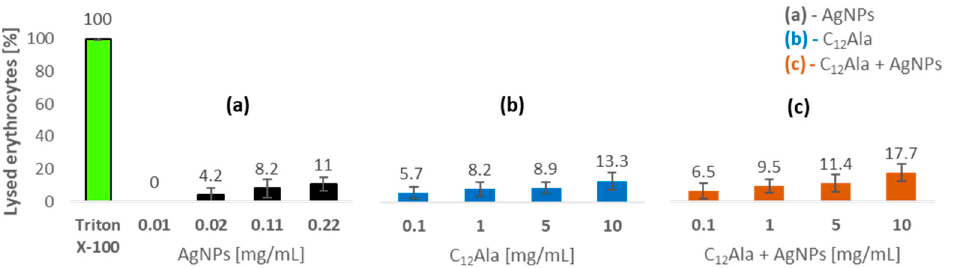
Figure 11. Hemolytic activity of AgNPs and gelators measured by percent of lysed erythrocytes compared to control (Triton X-100). ( a ) AgNPs; ( b ) C 12 Ala; ( c ) C 12 Ala-AgNPs.